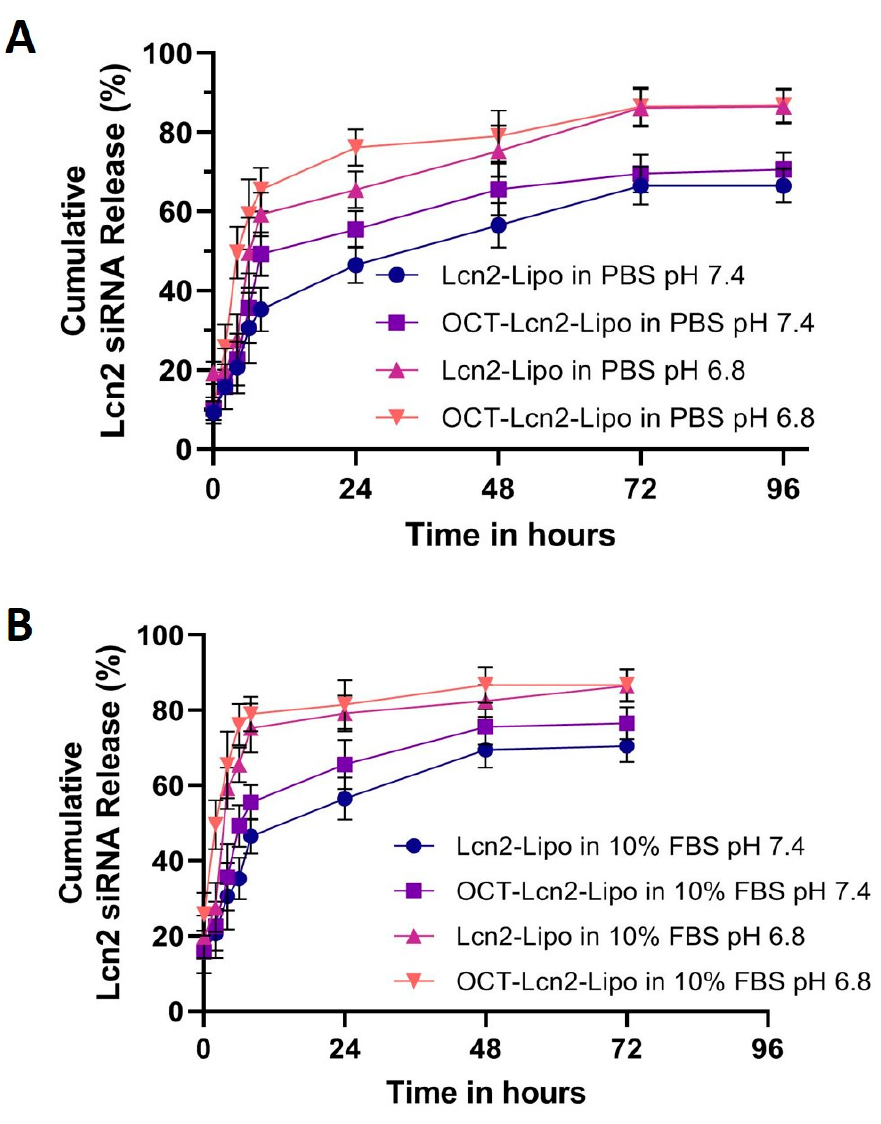
Figure 5. Dissolution of Lcn2 siRNA OCT-Lcn2-Lipo and Lcn2-Lipo liposomal formulations. ( A ) Cumulative release of Lcn2 siRNA from OCT-Lcn2-Lipo and Lcn2-Lipo in 1 × PBS at pH 7.4 and pH 6.8. ( B ) Cumulative release of Lcn2 siRNA from OCT-Lcn2-Lipo and Lcn2-Lipo in 10% Fetal Bovine serum in 1 × PBS at pH 7.4 and pH 6.8. The data were expressed as mean ± SD ( n = 3). Table 3. OCT-Lcn2-Lipo dilution study. DDI Water Dilution Factor